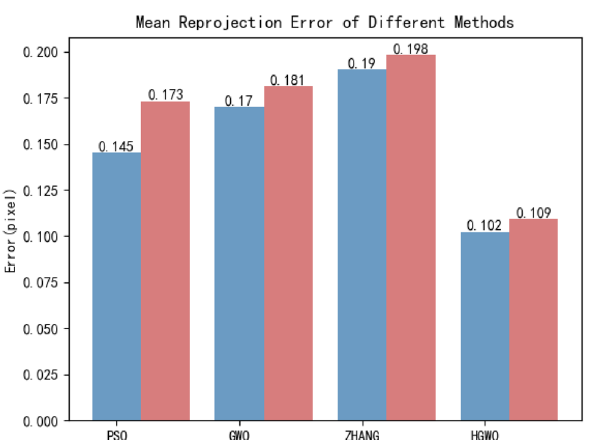
Figure 6. Comparison of the original calibration image and the image with added